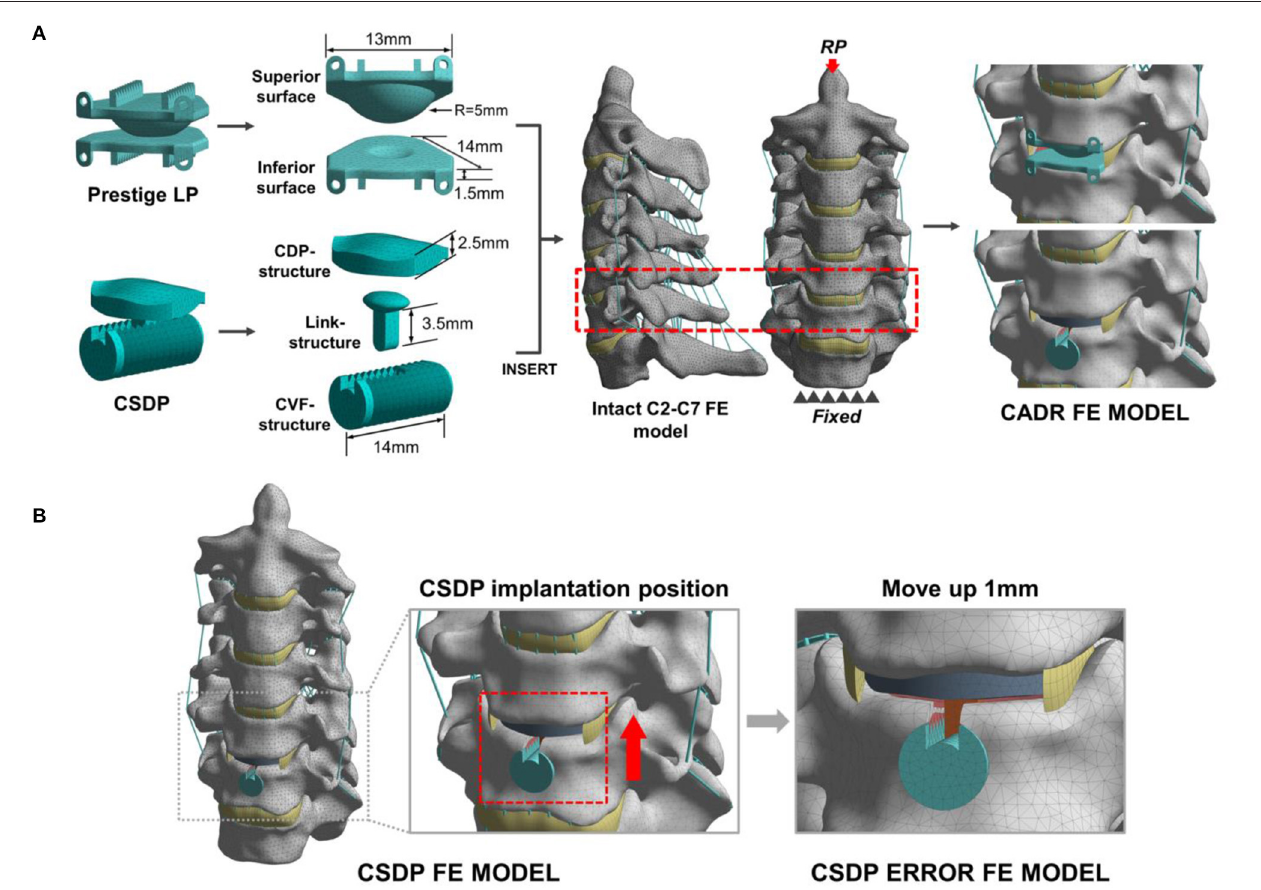
FIGURE 3 | Development and experimental conditions of the cervical artificial disc replacement (CADR) FE model. (A) The Prestige LP finite element (FE) model was composed of superior surface and inferior surface structures. The cervical subtotal discectomy prosthesis (CSDP) FE model was divided into three parts: cervical disc prosthesis (CDP) structure, cervical vertebra fixation (CVF) structure, and link structure. The Prestige LP and CSDP FE models were implanted at C 5 -C 6 . (B) The CSDP was moved up by 1mm to simulate an imprecise surgical insertion situation as a CSDP error FE model.